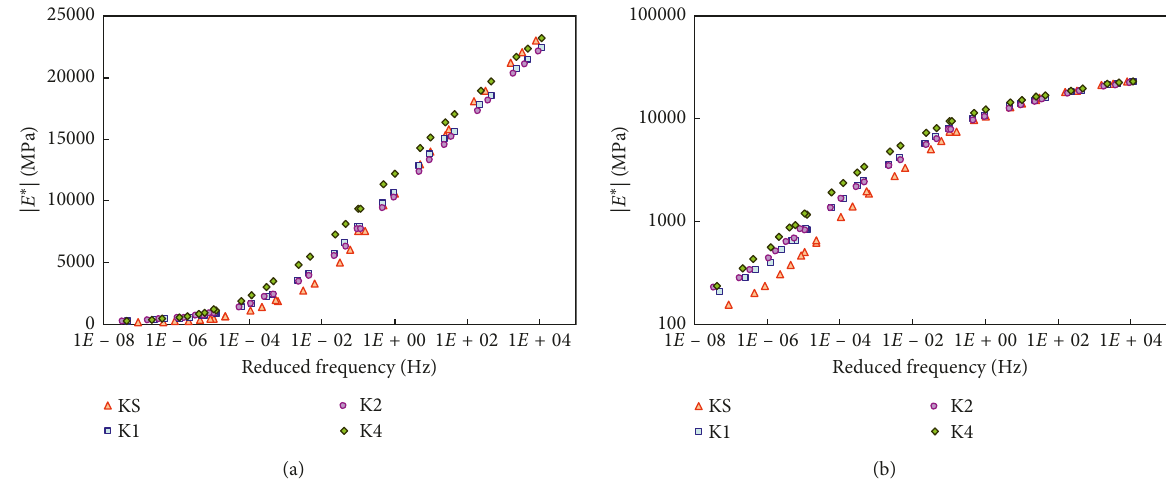
Figure 4: Dynamic modulus master curves for all four mixtures in (a) semilog space and (b) log-log